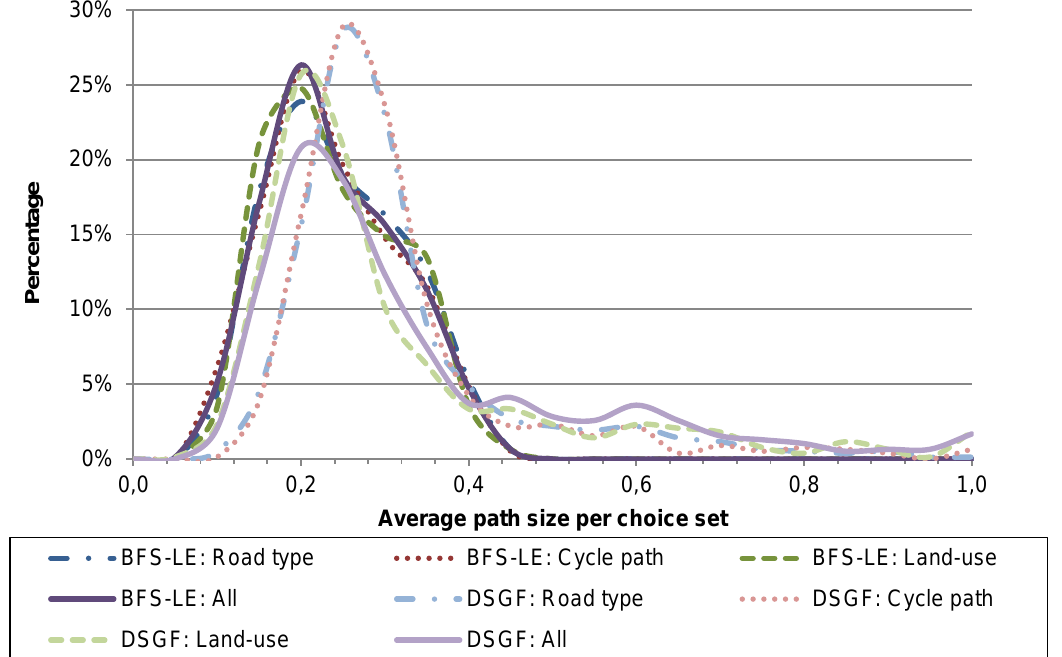
Figure 5. Path size distribution for the resulting route